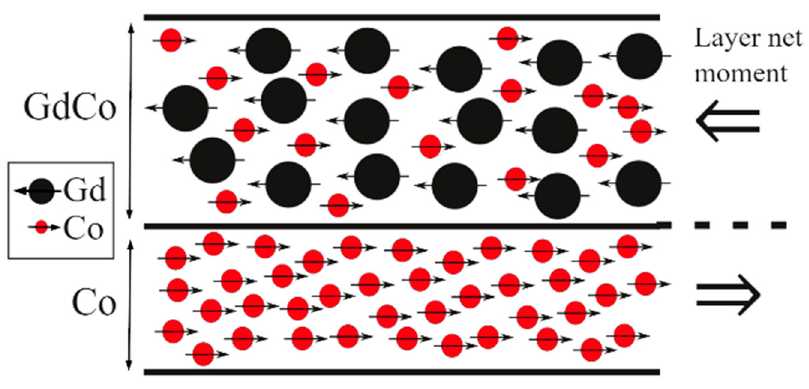
Figure 3. Schematic of a bilayer structure that is repeated 20 times to form a ferrimagnetic multilayer Si/[Gd 0.5 Co 0.5 /Co] x20 . There is a double ferrimagnetic order: one of the layers is a Gd 1 − x Co x alloy and the whole multilayer shows a ferrimagnetic order as neighbouring layers point in opposite directions.